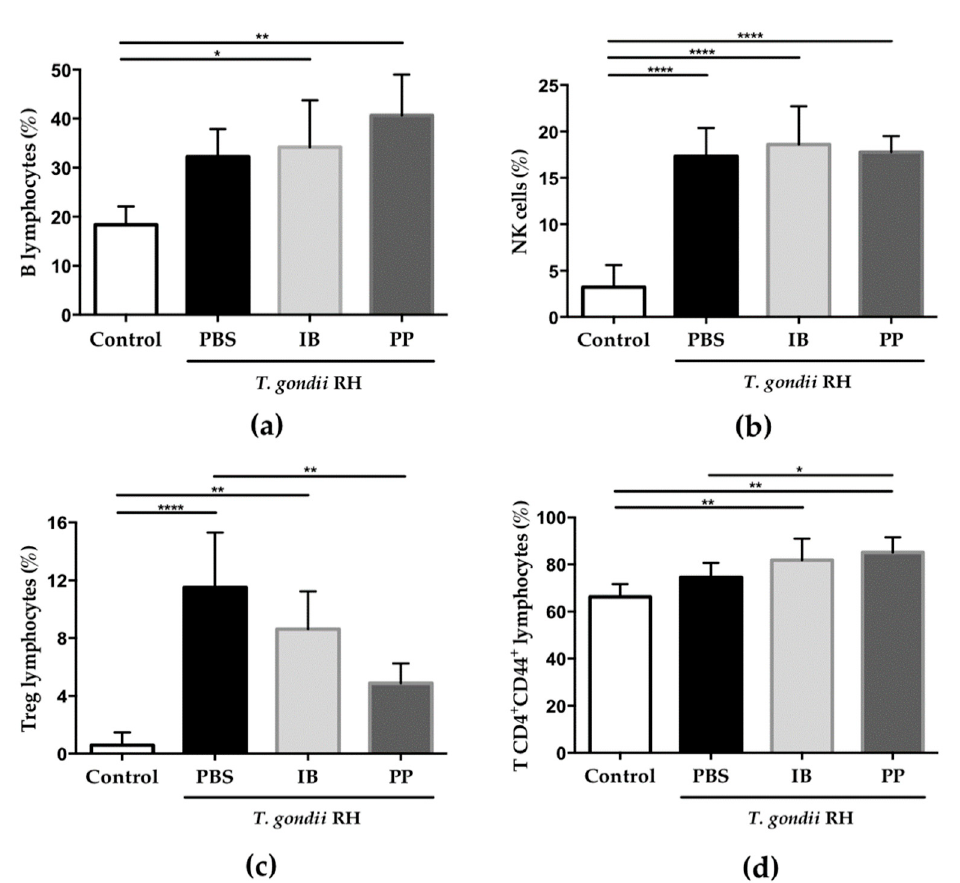
Figure 5. Determination of the percentage of the spleen cell populations on the seventh day post-infection with T. gondii RH. Splenocytes were labeled with different monoclonal antibodies for B lymphocytes ( a ), Natural Killer cells ( b ), regulatory T lymphocytes ( c ), and T CD4 + CD44 + lymphocytes ( d ) Data were combined from two individual experiments with three to five mice per group. Values represent the means ± SD. * p < 0.05; ** p < 0.01; **** p < 0.0001. PBS) phosphate buffered saline; IB) immunobiotic; PP) paraprobiotic.